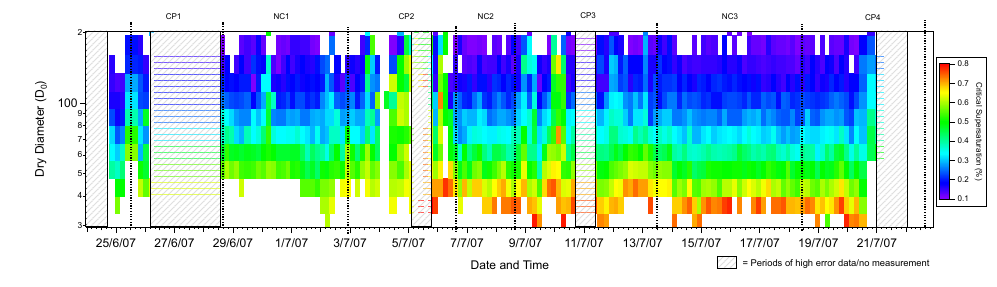
Fig. 3. Time series of S c ,D for the duration of the experiment. Larger particles typically require less supersaturation to activate and thus 0 have a lower S c ,D . Some variation in S c ,D is apparent, but does not correspond strongly to changes in the AMS organic:sulphate 0 0